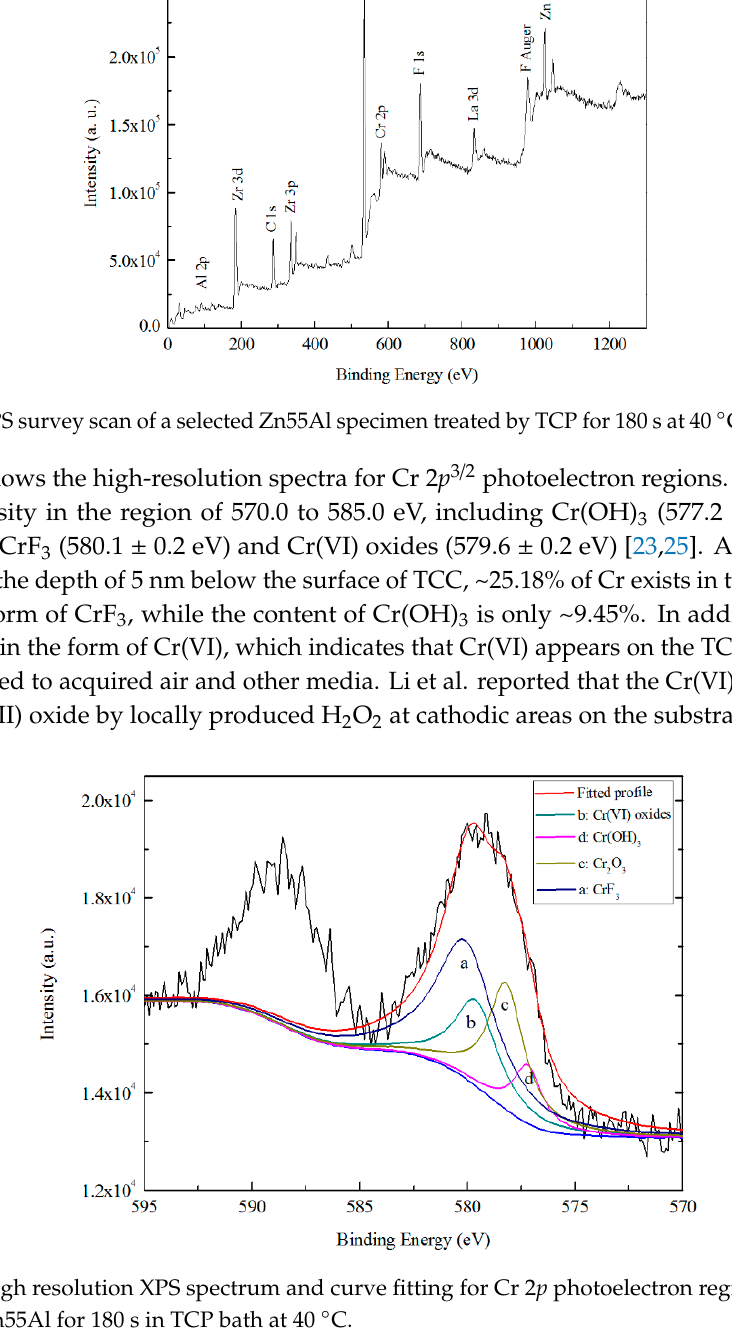
12 of 21 Figure 11. AES elemental atomic in-depth distribution of selected points on TCC formed by 180 s at 40 ° C in the TCP bath: ( a , b ) dendritic region and ( c , d ) inter-dendritic region. In the inter-dendritic region, the contents of chromium, zirconium, and oxygen reached their maximum value at 300 nm. The ratio of Cr/Zr increased from ~1.86 at 50 nm depth to ~5.92 at 300 nm, slightly larger than that at dendritic region. Figure 11c,d show that the element zinc and aluminum reached a larger content at ~410 nm, indicating that the main distribution of TCC at the inter-dendritic region was slightly thicker than that in dendritic region. However, the stratification phenomenon in the inter-dendritic zone is not as obvious as that in the dendritic zone. As an important participant in TCC formation, fluorine is widely distributed in the conversion coating. In addition, the carbon content detected in the surface layer of TCC in the inter-dendritic zone is very high, the probably